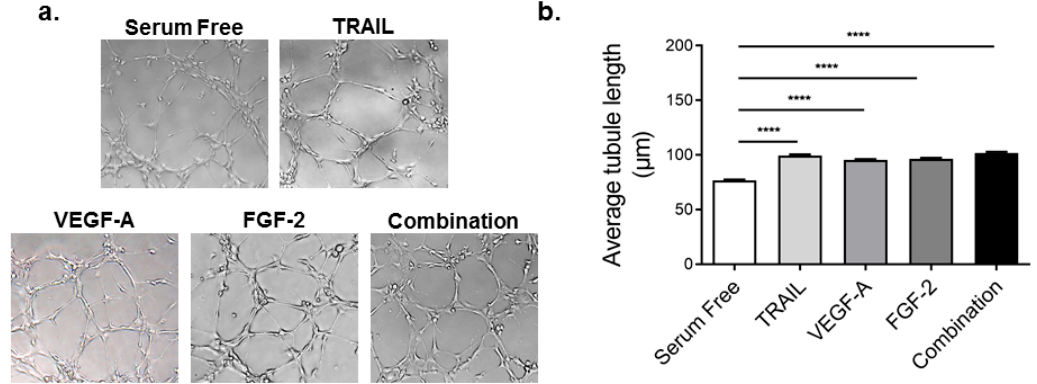
Figure 3. TRAIL promotes HMEC-1 tubule formation better than VEGF-A, yet comparable to FGF-2 and combination therapy. Serum-starved HMEC-1 cells were seeded into growth factor reduced Matrigel and treated with TRAIL (10 ng/mL), VEGF-A (10 ng/mL), FGF-2 (10 ng/mL) or the combination of all three (each at 10 ng/mL). Images were taken 24 h later. ( a ) Representative images 10× magnification; ( b ) tubule length was measured ( n = 3/condition). Results are expressed as the mean ± SEM; ANOVA; **** p < 0.0001.